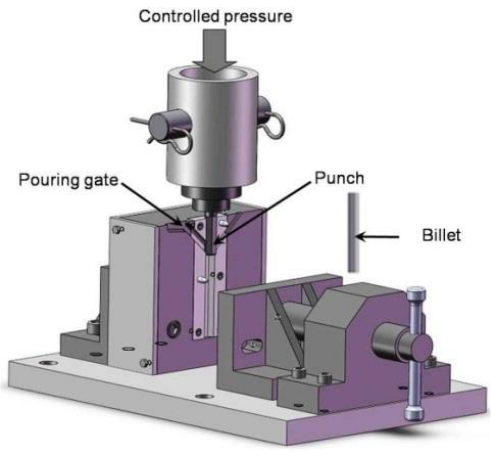
Figure 7. Schematic representation of squeeze casting